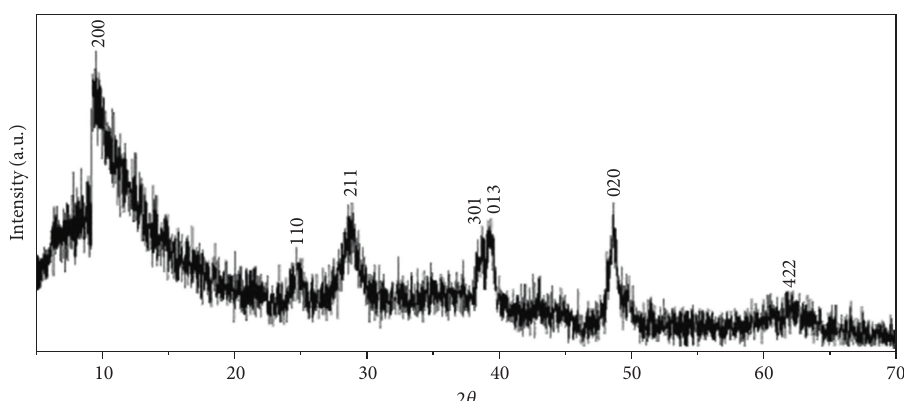
Figure 1: XRD of the Na-TiNT showing the characteristic shape of nanotube diffraction